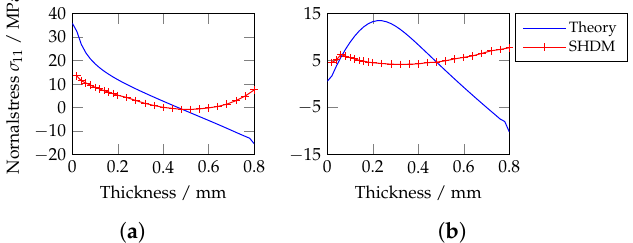
Figure 12. Comparison of the theoretical residual stress and the predicted residual stress state using the simulated hole drilling method for the out-of-plane waviness “Sinus D1”. The comparison is done at the two characteristic positions (Figure 9). It can be clearly observed that the induced fiber imperfection lead to recognizable deviations. ( a ) Pos. 1; ( b ) Pos.